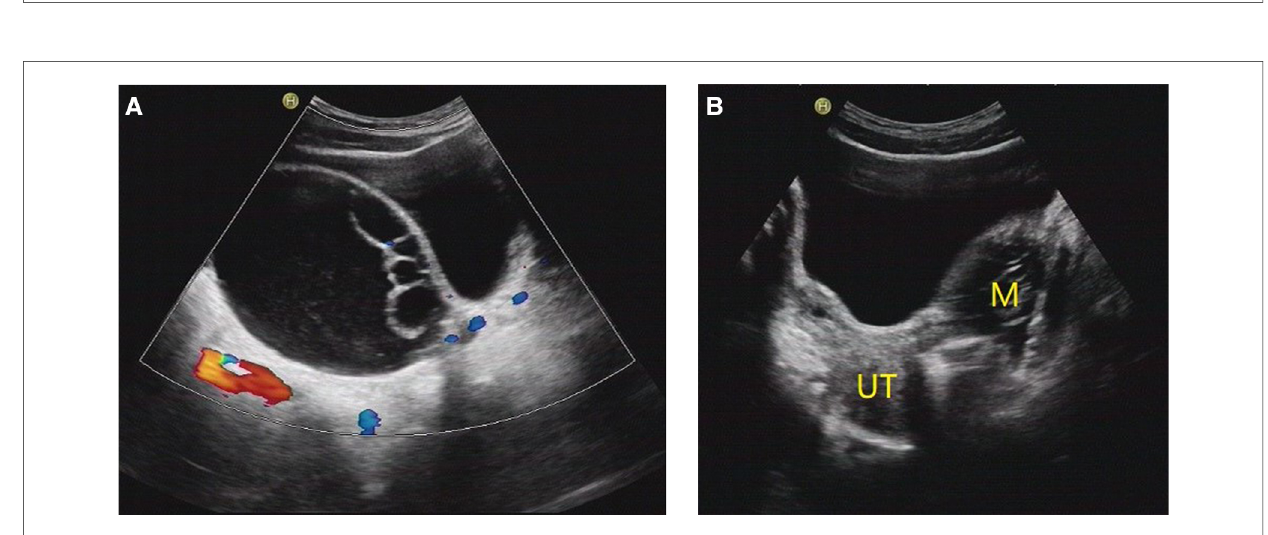
FIGURE 2 O-RADS 2, maximum diameters of lesion 79 mm, pathology: mature teratoma. ( A ) Unilocular cyst, no solid elements, color score 1; ( B ) The mass was located beside the right ovary. M, mass; RO, right ovary; BL, bladder.